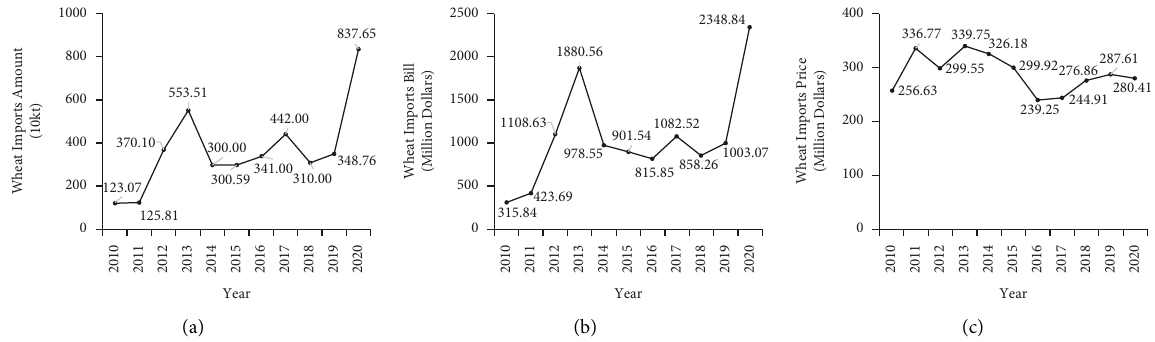
Figure 5: The total annual wheat imports amount, bill, and price of China from 2010 to 2020. (a) The total annual imports amount of wheat in China from 2010 to 2020; (b) the total annual imports bill of wheat in China from 2010 to 2020; (c) the total annual imports price of wheat in China from 2010 to 2020.